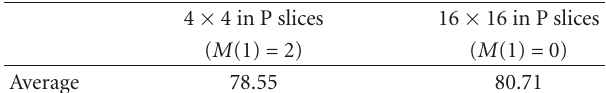
Table 5: Skipped block ratio [%] with integer motion estimation